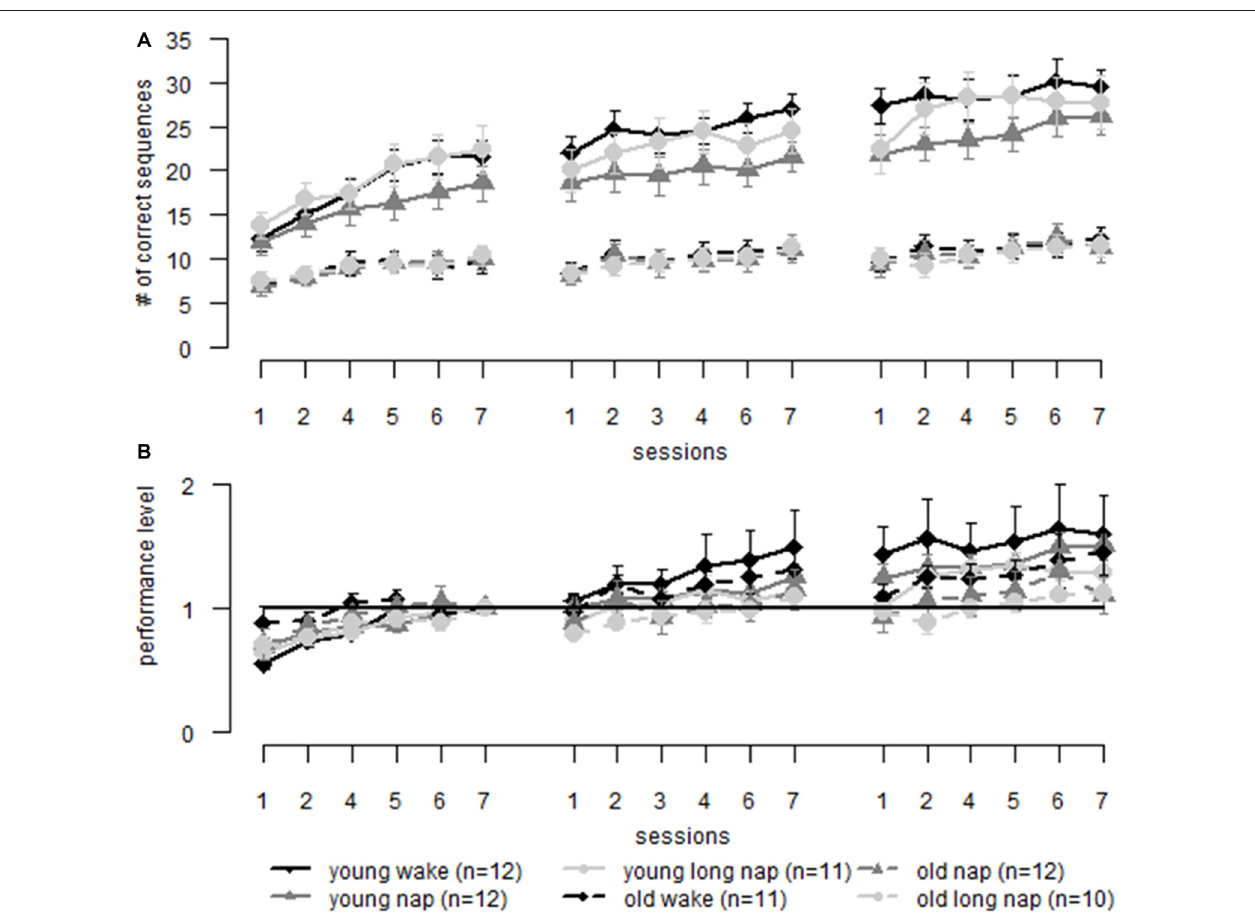
FIGURE 6 | Sequence learning: comparison of learning in older (dotted lines) and younger adults (solid lines) over three learning sessions including a midday break (first gap) and over-night sleep (second gap). (A) Raw data comparing young and older adults. (B) Learning data is normalized to the same pre-sleep level of learning (last block of the first session) in both young and old adults. Error bars represent the standard error of the mean.